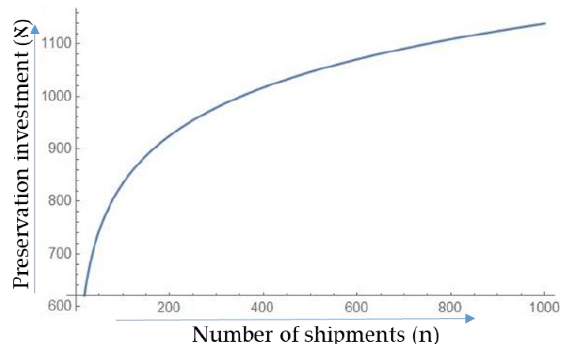
Figure 9. Impact of number of shipments on optimal preservation investment.